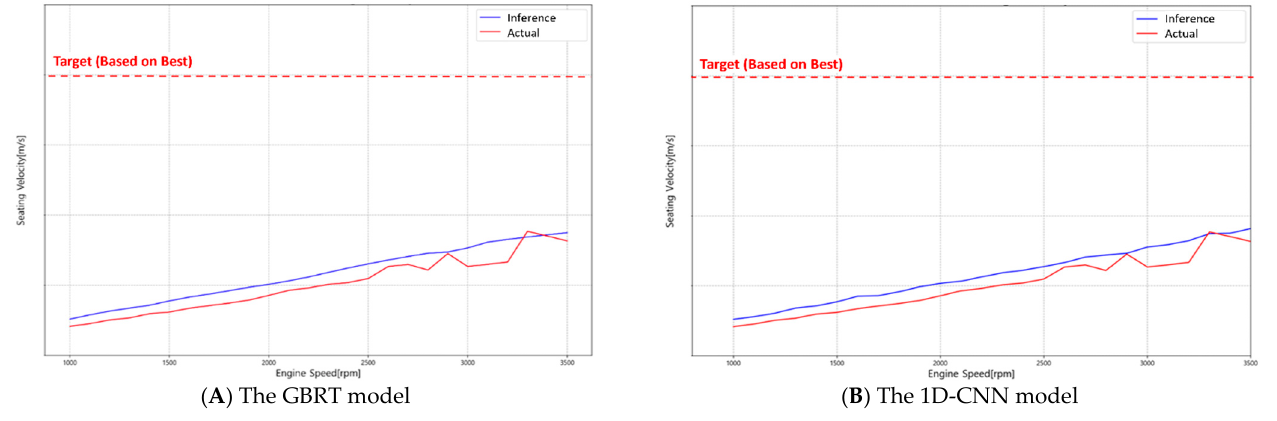
Figure A3. Comparing the actual and predicted values of the valve seating velocity by crank angle reference RPM using the GBRT and 1D-CNN models.